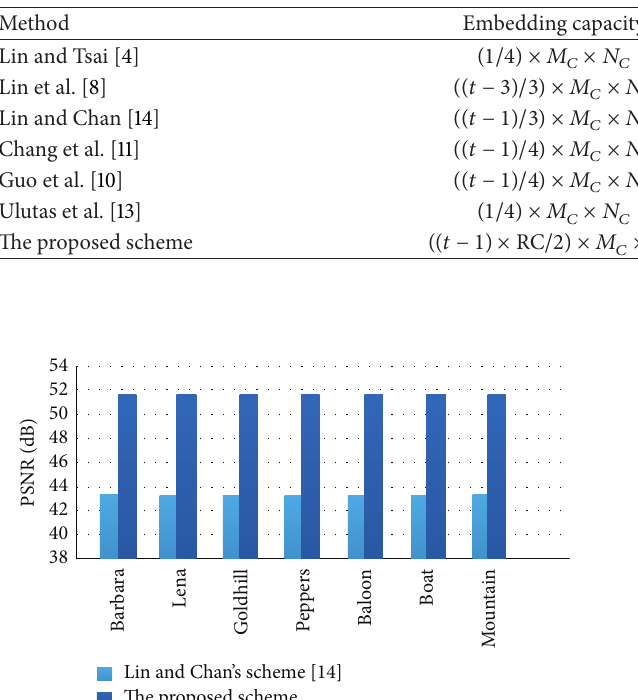
Table 9: Comparisons of the related schemes.